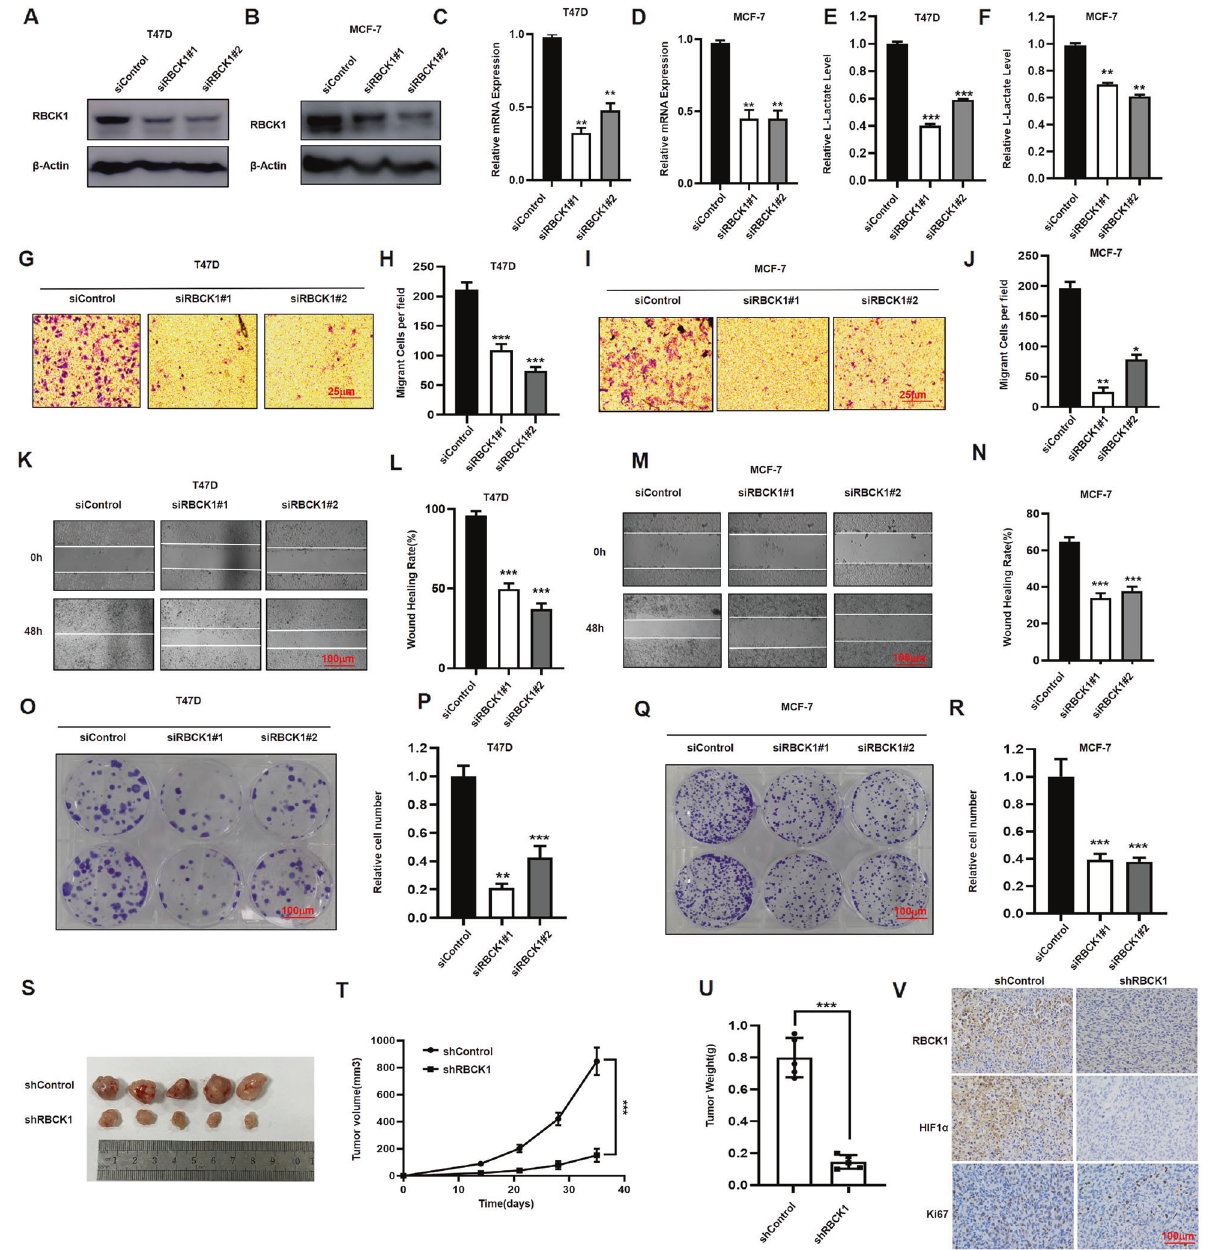
Fig. 1 RBCK1 depletion inhibits migration in ER-positive breast cancer cells. A – D RBCK1 was silenced in T47D and MCF-7, and its silencing effect was then detected by western blot technology and real-time PCR technology. E , F RBCK1 depletion under hypoxia reduced the level of energy metabolism in T47D and MCF-7 cells, which were transfected with siControl or siRBCK1. After 36 h, the cells were treated with hypoxia for 12 h, L-lactate level was determined by L-Lactate Assay Kit. G – J RBCK1 knockdown inhibits ER + cell migration in T47D and MCF-7 cells under hypoxia. We planted cells in a transwell chamber and looked under the microscope at the migration capacity of cells. We then counted and recorded the images obtained by ImageJ and then analyzed them with Prism 8.0, p < 0.05, which is statistically signi fi cant (* p < 0.05; ** p < 0.01; *** p < 0.001). K – N RBCK1 promotes migration in ER + breast cancer cells under hypoxia. Wound healing assay under hypoxia of T47D and MCF-7 cells were transfected with siControl or siRBCK1. The experiment should be repeated more than three times so that the results obtained are statistically signi fi cant. O – R RBCK1 depletion inhibits the ability of colony formation in T47D and MCF-7 cells under hypoxia. Crystal violet staining assay evaluated the ability of colony formation of MCF-7 and T47D cells with the silence of RBCK1, and the quantitative analysis is displayed (right). The data are presented by the means ± SD ( n = 3). (* p < 0.05; ** p < 0.01; *** p < 0.001). S – U RBCK1 knockdown inhibits tumor growth of T47D cells in xenografted models. After the tumor is planted in mice, the growth status of mouse transplant tumor is monitored. After fi ve weeks, mice are sacri fi ced, and measurements and follow-up experiments are performed. * p < 0.05, ** p < 0.01, *** p < 0.001 for student ’ s t-test. V IHC staining shows that the expression of Ki67 and HIF1 α decreased after RBCK1 knockdown. IHC staining of Ki67, RBCK1, and HIF1 α in xenograft model tumor.